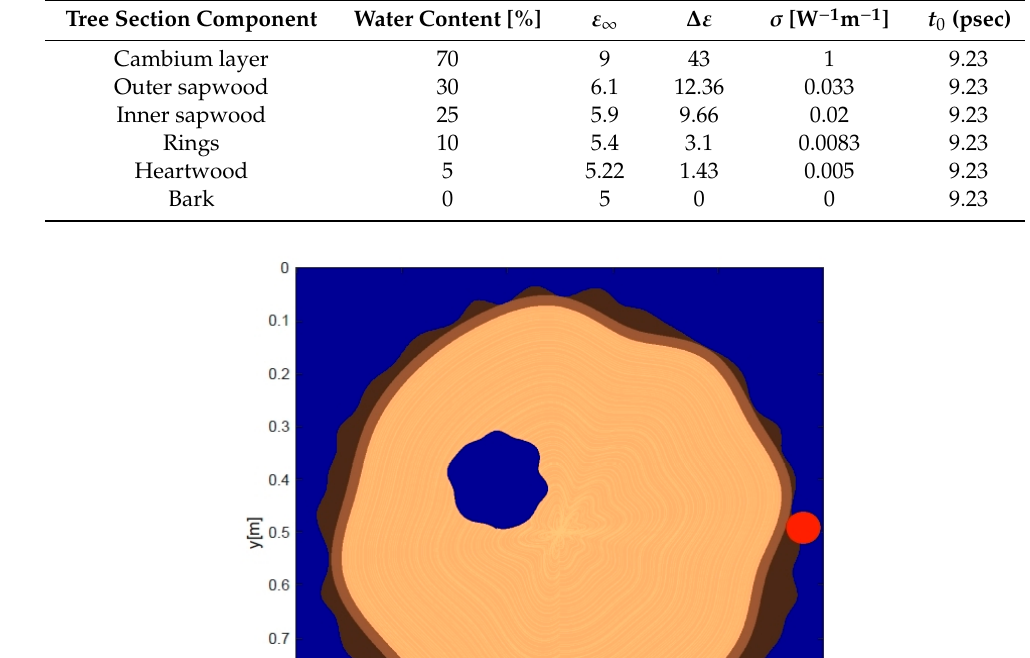
Figure 4. The complex-shaped hardwood trunk scenario investigated using FDTD numerical modelling. The starting point of the measurements, taken clockwise, is represented by the red circle. 3.2. Real Data Acquisitions The real data presented in this work were collected from a dead oak tree at The Faringdon Centre —Non-Destructive Testing Centre, University of West London (UWL), UK. Three holes were drilled and subsequently filled with sawdust mixed with water. This operation was carried out to simulate rotting spots within the trunk cross-section. The 2 GHz Aladdin hand-held antenna system, manufactured by IDS GeoRadar (Part of Hexagon), was used for testing purposes. Measurements were collected every 1 cm counter-clockwise using the measuring wheel adapted to the antenna with a time-step Δ t = 7.8125 ps along the trace. Figure 5 shows a picture of the investigated tree trunk. It is important to mention that the acquisition time required for a single 2D scan encircling the trunk (i.e.,